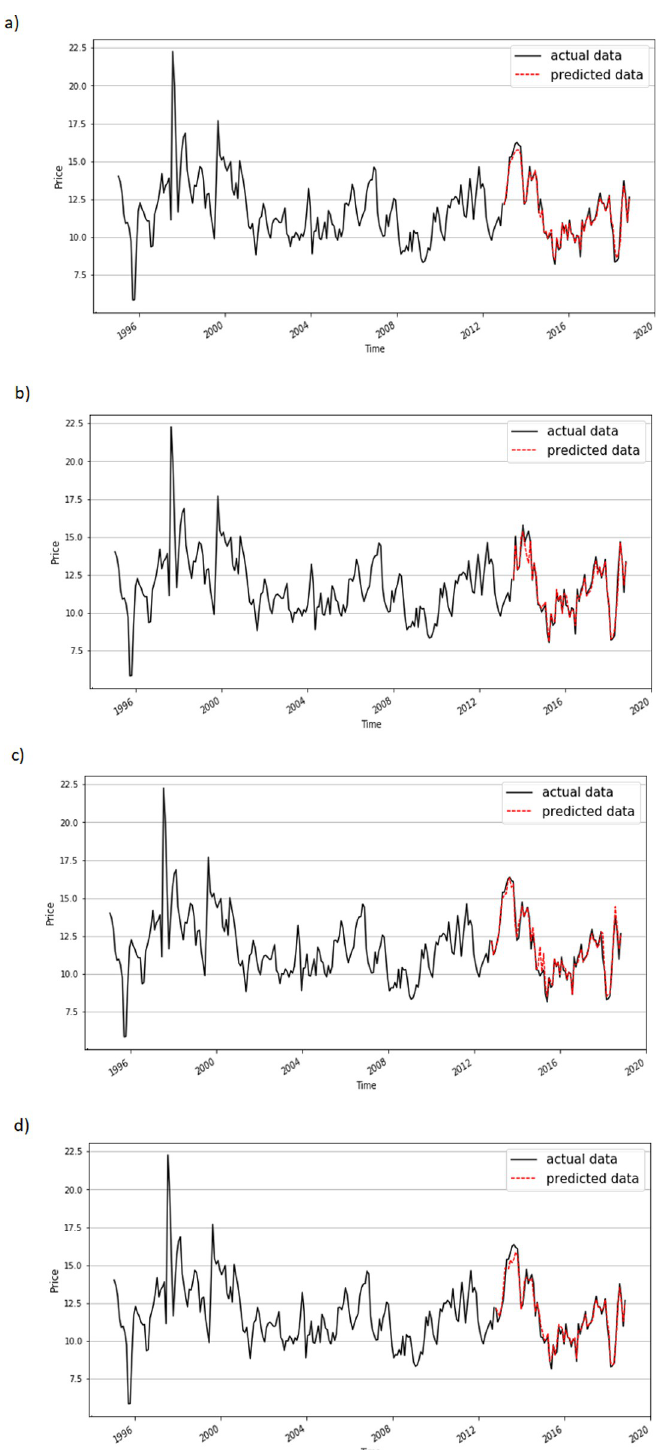
Fig 3. a. Prediction for a 3-month base by the super learner. b. Prediction for a 6-month base by the super learner. c. Prediction for a 9-month base by the super learner. d. Prediction for 12-month base by the super learner.